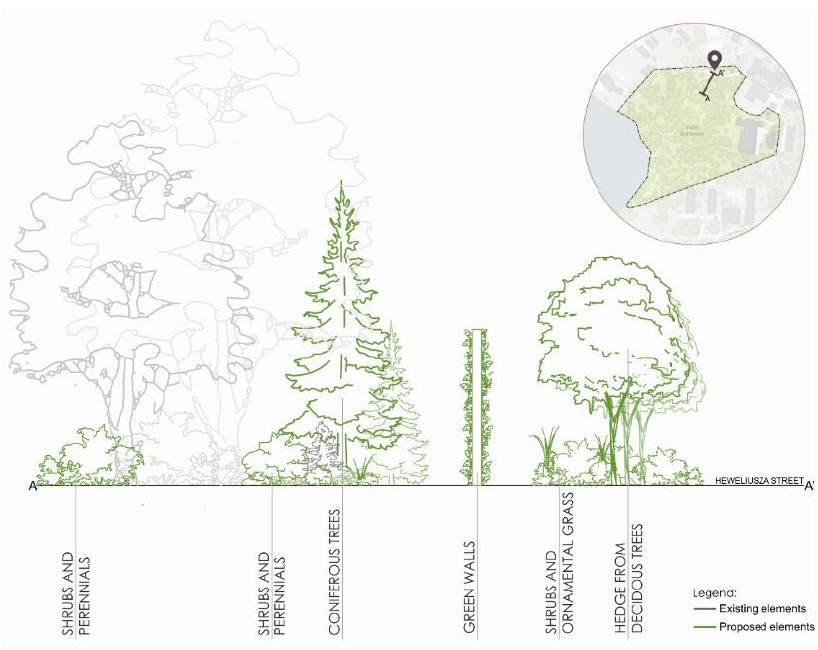
Figure 9. Scheme for re-design of the A zone in Kortowo Park.